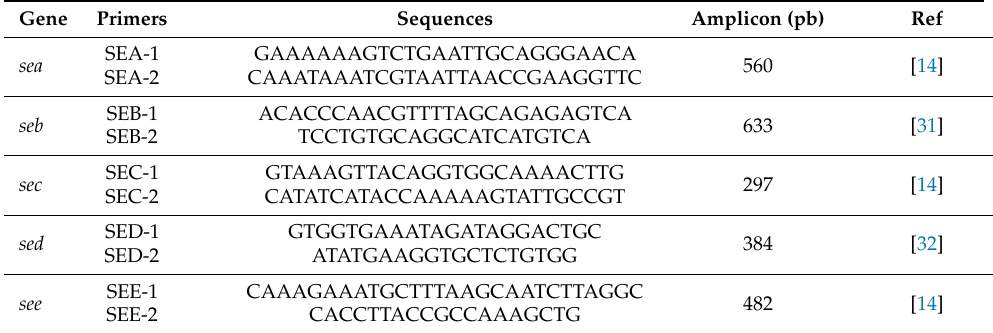
Table 1. Primers used in the investigation of enterotoxin genes in coagulase-positive staphylococci.